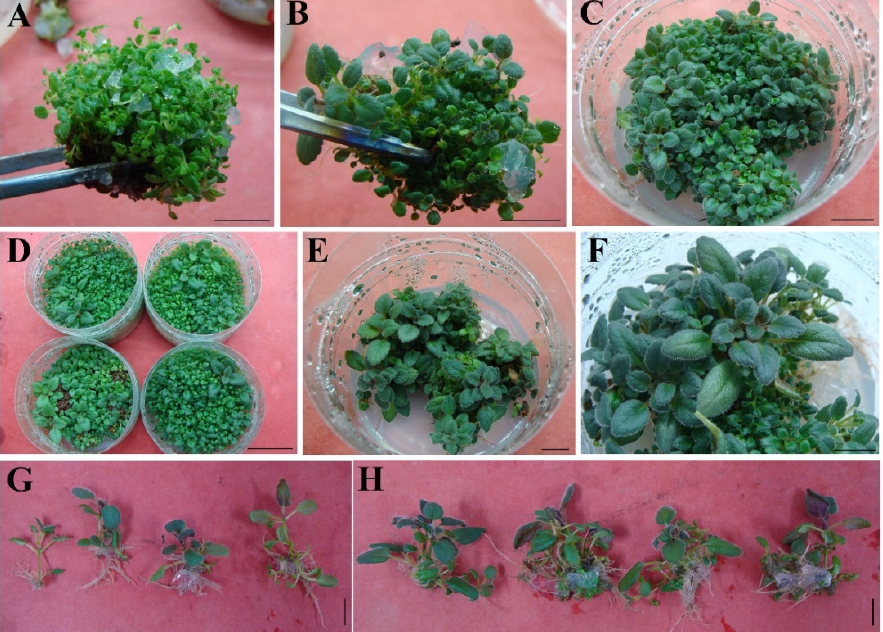
Figure 3. Regenerated shoot elongation and rooting of Sinningia hybrida ‘Isa’s Murmur’. ( A ) Adven- titious buds on MS medium containing 2.0 mg L − 1 TDZ and 0.1 mg L − 1 NAA. ( B – D ) Elongated buds from MS medium containing 0.5 mg L − 1 GA 3 combined with 0.1 g L − 1 casein, 0.2 mg L − 1 IBA, and 1.0